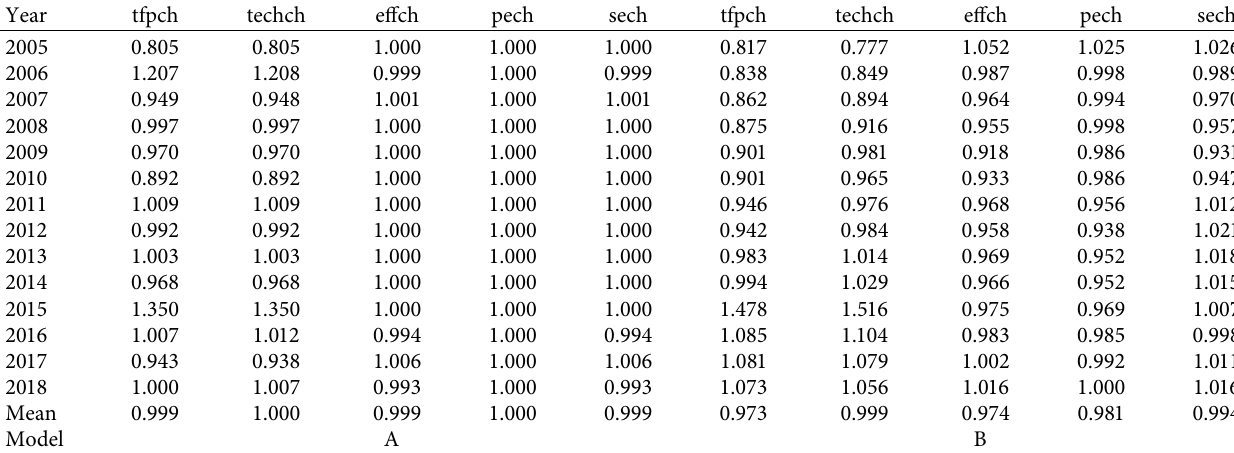
Table 4: Malmquist Index summary of annual